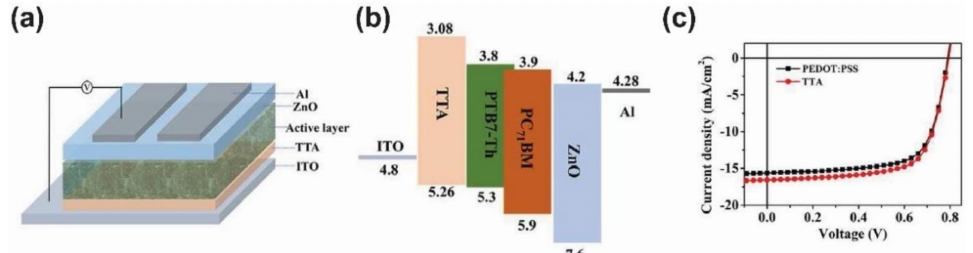
Figure 20. ( a ) Illustration of OSCs structure based on TTA, ( b ) energy level diagram of different layers, and ( c ) J-V curves of devices with TTA and PEDOT:PSS as HTLs. Adapted with permission from [377]. Copyright 2020,